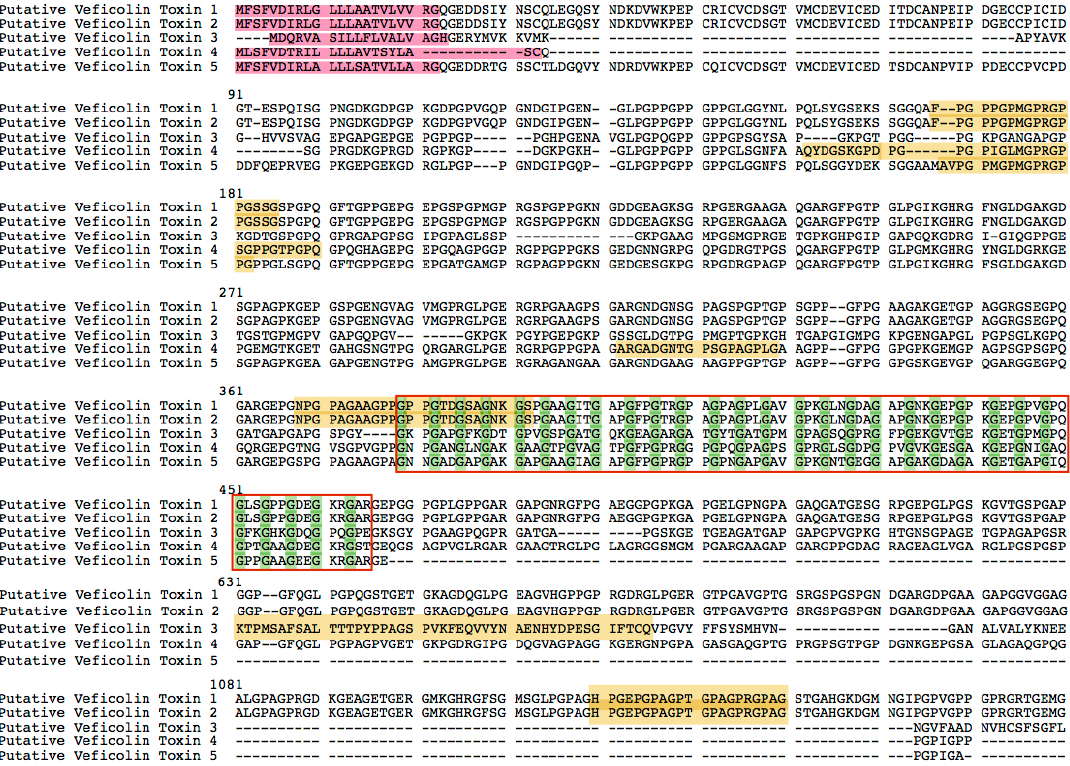
Figure 5. The putative Veficolin toxin sequences from Chinese yellow catfish. Sequences in red background are signal peptides. Peptides in yellow background are verified by LC-MS/MS analysis. The amino acid Glycine are marked in green color. The G-X-Y repeats are included in the red box. Dashed lines means the absence of corresponding amino acid sequences.